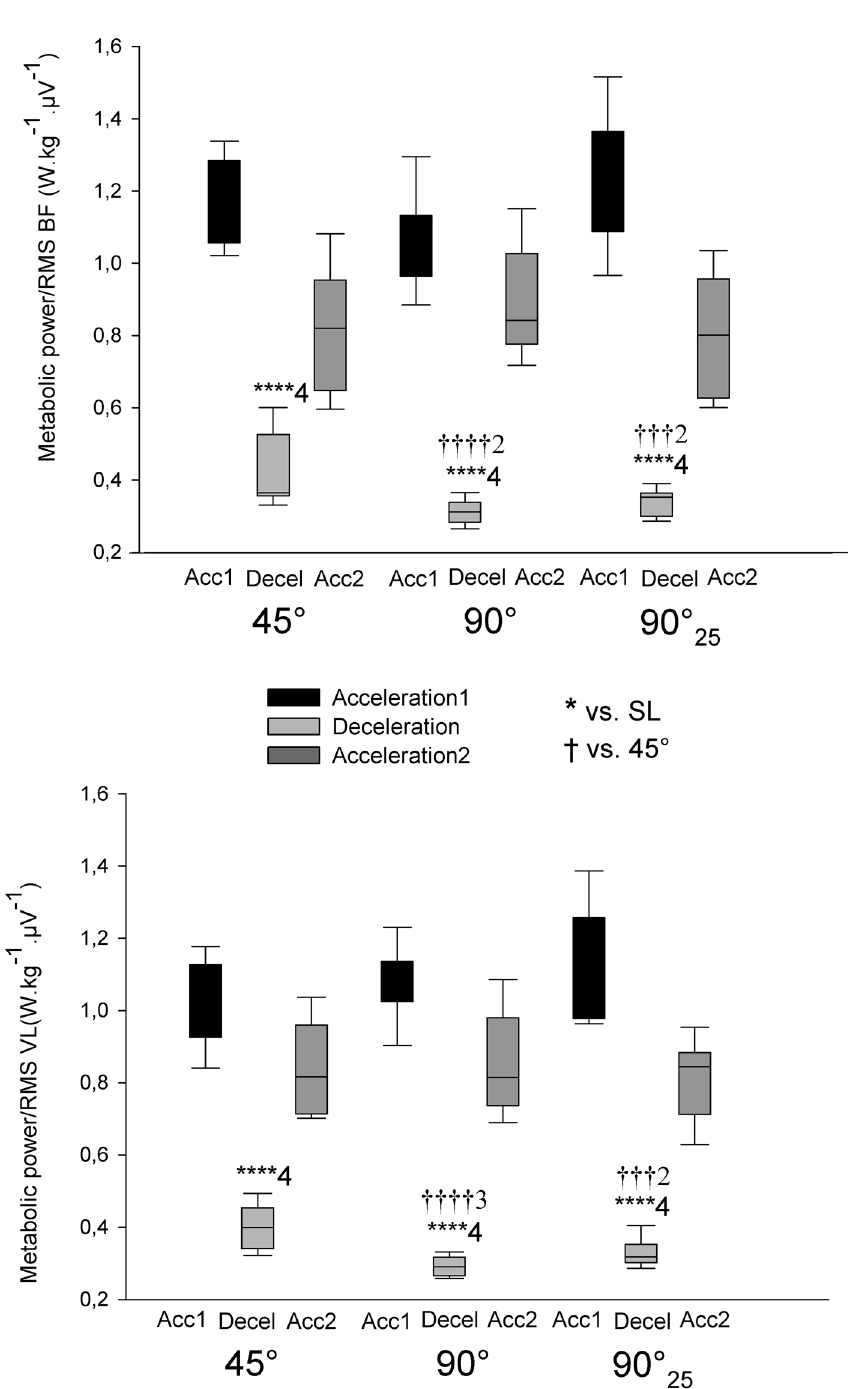
Fig 7. Metabolic power/electromyography amplitude (RMS) ratio during the different phases of sprints with (45° or 90°) or without (i.e., straight-line (SL)) one change of direction (COD). 90° 25 : 25-m sprint with one 90°-COD; BF: biceps femoris; VL: vastus lateralis. The number of ‘ * ’ and ‘†’ refers to possible, likely, very likely and almost certain difference versus straight-line and 45°-COD sprints, respectively. The associated numbers represent the magnitude of the standardized difference, with 1 standing for small, 2 for moderate, 3 for large and 4 for very large